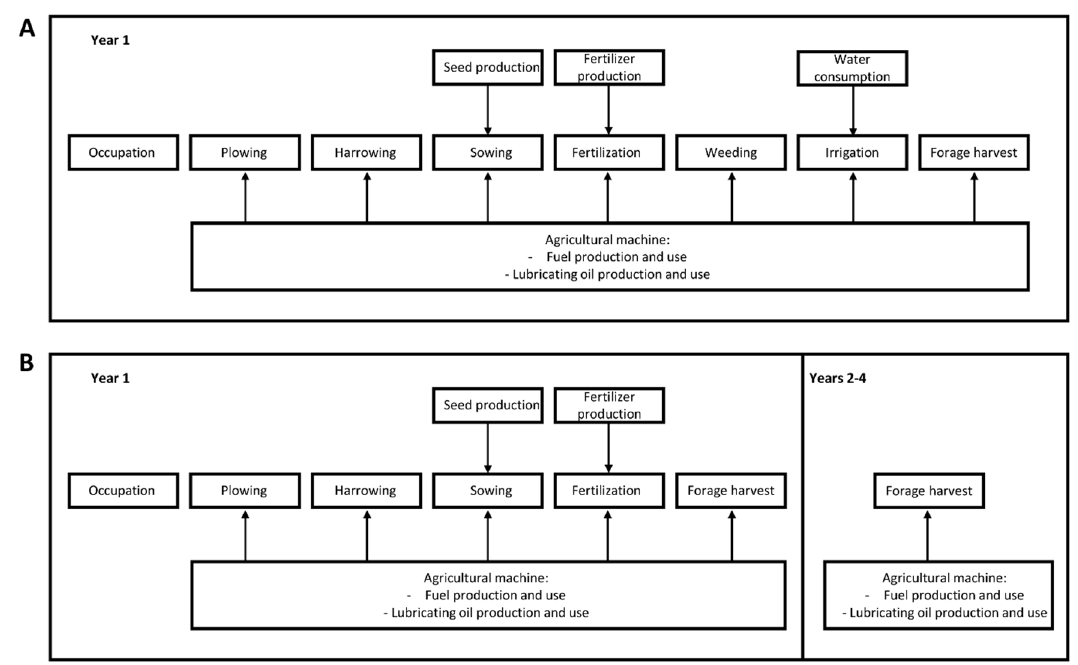
Figure 1. System boundaries of ( A ) maize (annual crop) and ( B ) alfalfa (poliannual crop).